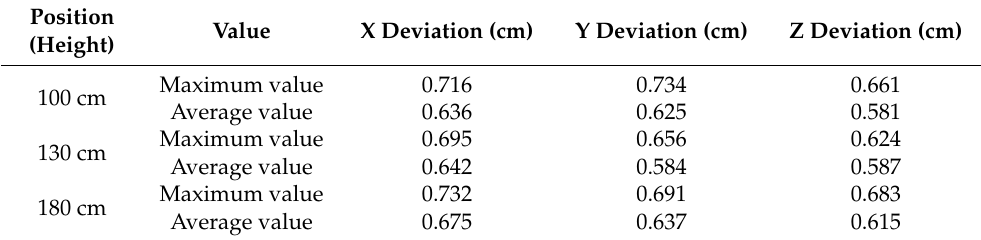
Table 1. Results of positioning